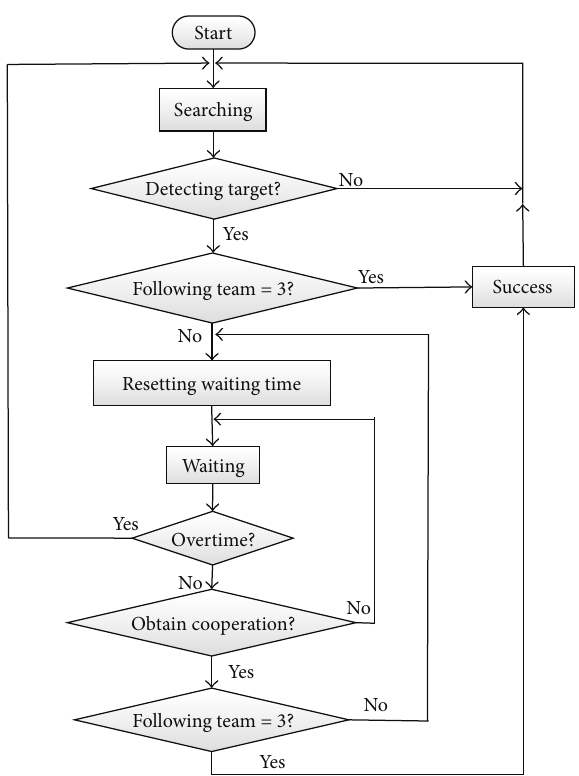
Figure 2: The flowchart of cooperative hunting behavior.